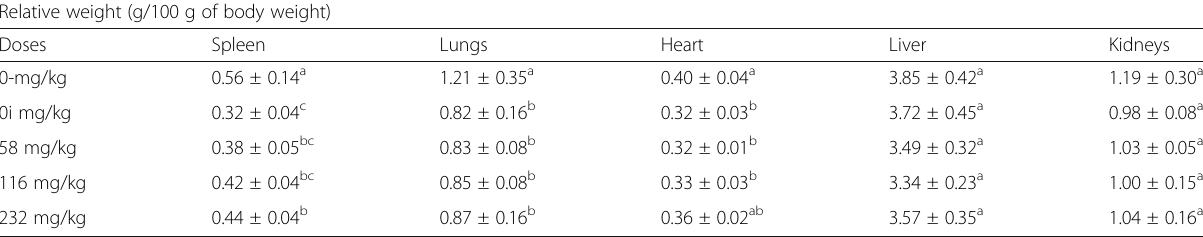
Table 7 Organ to body weight ratios as affected by infection and doses of A. cordifolia extract after 2 weeks of administration to rats Relative weight (g/100 g of body weight) Doses